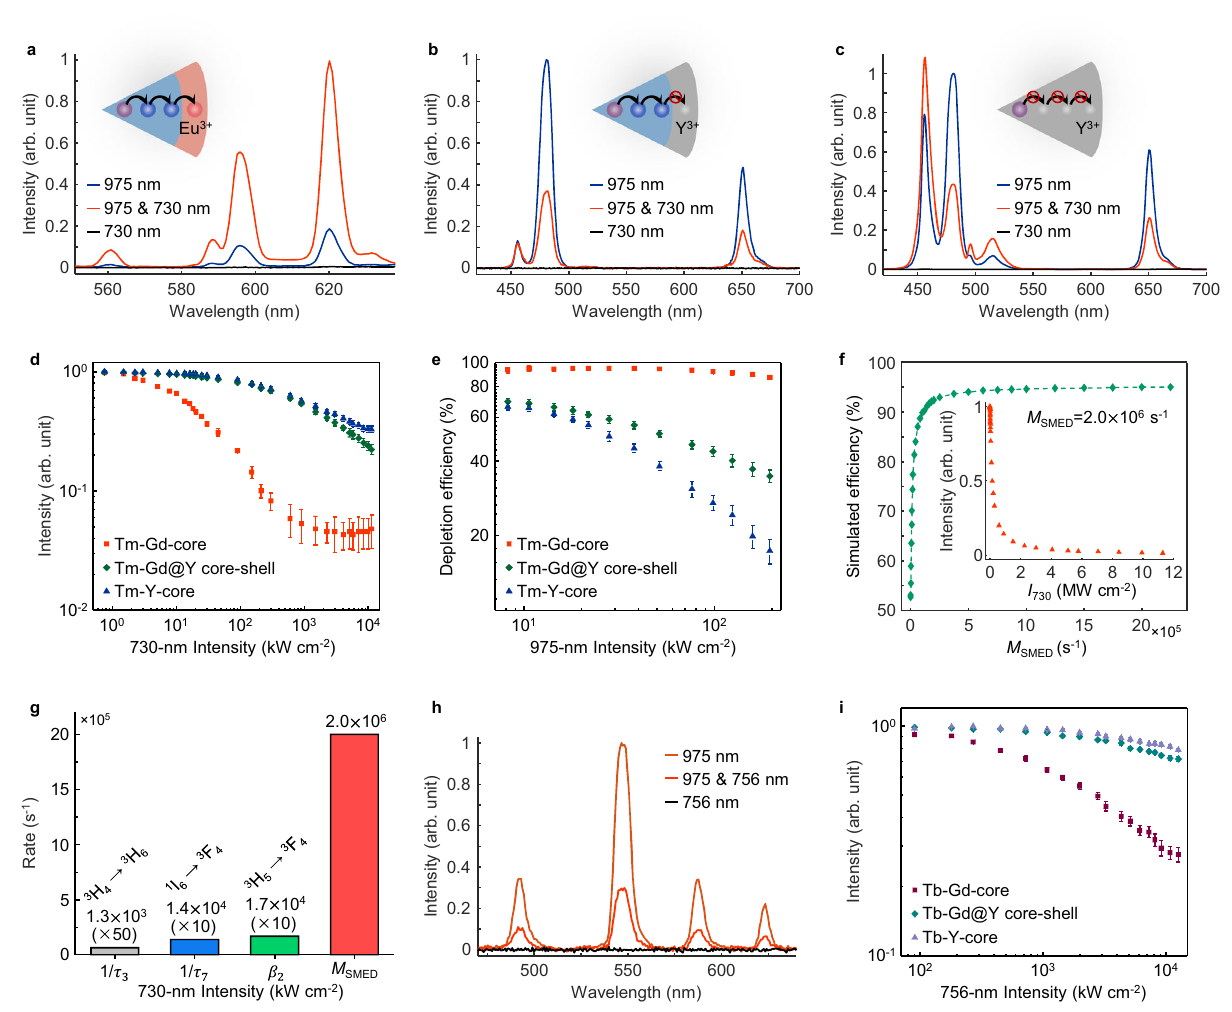
Fig. 3 | Spectroscopic investigations of SMED using Tm 3+ -activated and Tb 3+ - activated nanoparticles. a – c Spectra of NaGdF 4 :Yb/Tm (18/0.3%)@NaGdF 4 :Eu (15%),NaGdF 4 :Yb/Tm(18/0.3%)@NaYF 4 ,andNaYF 4 :Yb/Tm(18/0.3%)nanoparticles, respectively, co-irradiated with different CW lasers ( I 975 =21.7kWcm − 2 ; I 730 =3.01 MWcm − 2 ). d , e Comparison of the depletion- or excitation intensity-dependences among NaGdF 4 :Yb/Tm (18/0.3%), NaGdF 4 :Yb/Tm (18/0.3%)@NaYF 4 and NaYF 4 :Yb/ Tm (18/0.3%) nanoparticles ( I 975 =21.7kWcm − 2 ; I 730 =3.01MWcm − 2 ). f Numerical simulation of the relationship between optical depletion of the 1 G 4 state and the effect of the SMED mechanism. The inset shows the simulated depletion intensity- dependences when M SEMD is 2.0×10 6 s − 1 . g Comparison of the energy dissipation